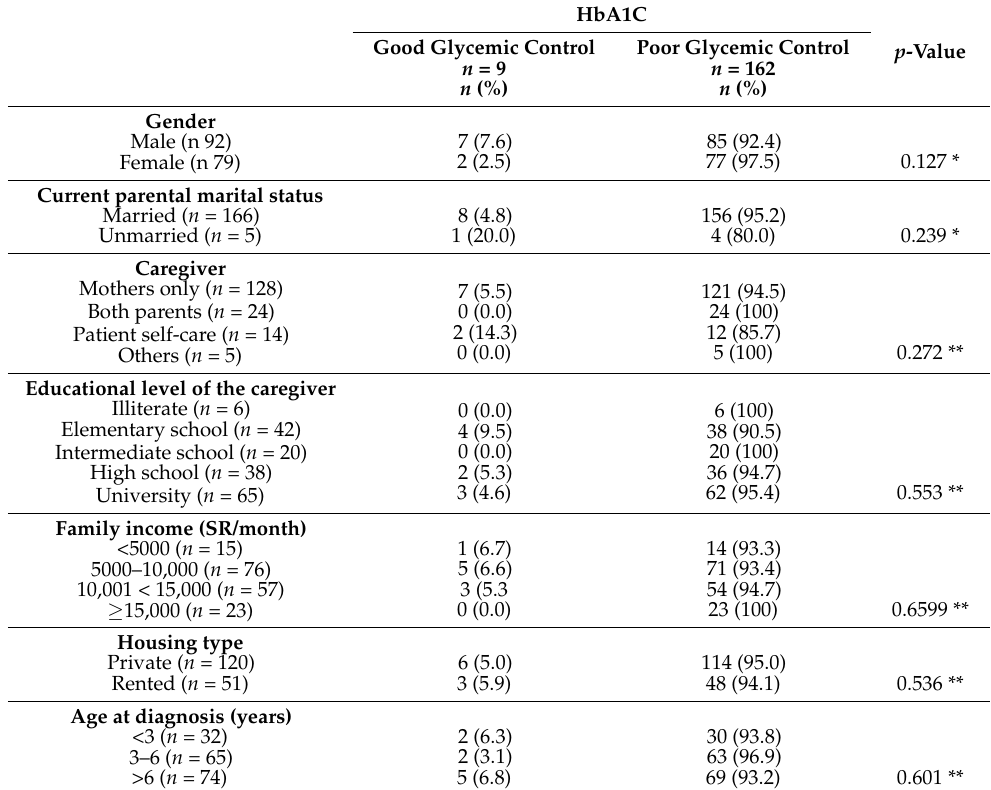
Table 1. Socio-demographic factors associated with level of HbA1c among children in Aseer Region.